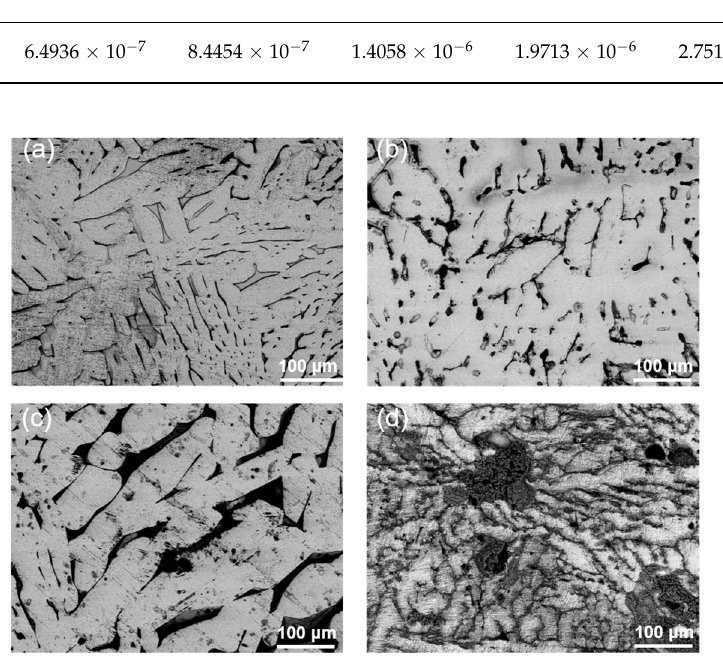
Figure 13. SEM images of corroded surface of Z3CN20-09M stainless steel under different thermal aging time ( a ) 0 h, ( b ) 1000 h, ( c ) 3000 h, ( d ) 15,000 h.